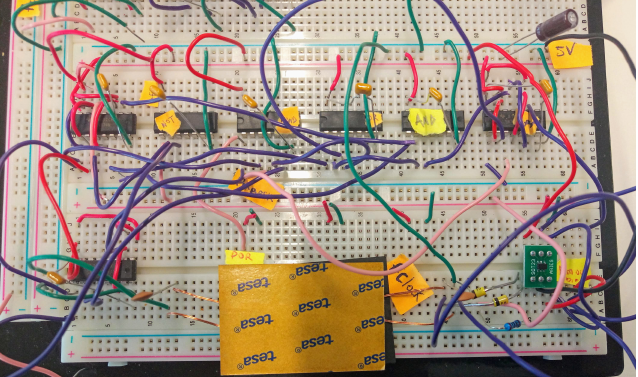
Figure 8. Downlink receiver demonstrator: